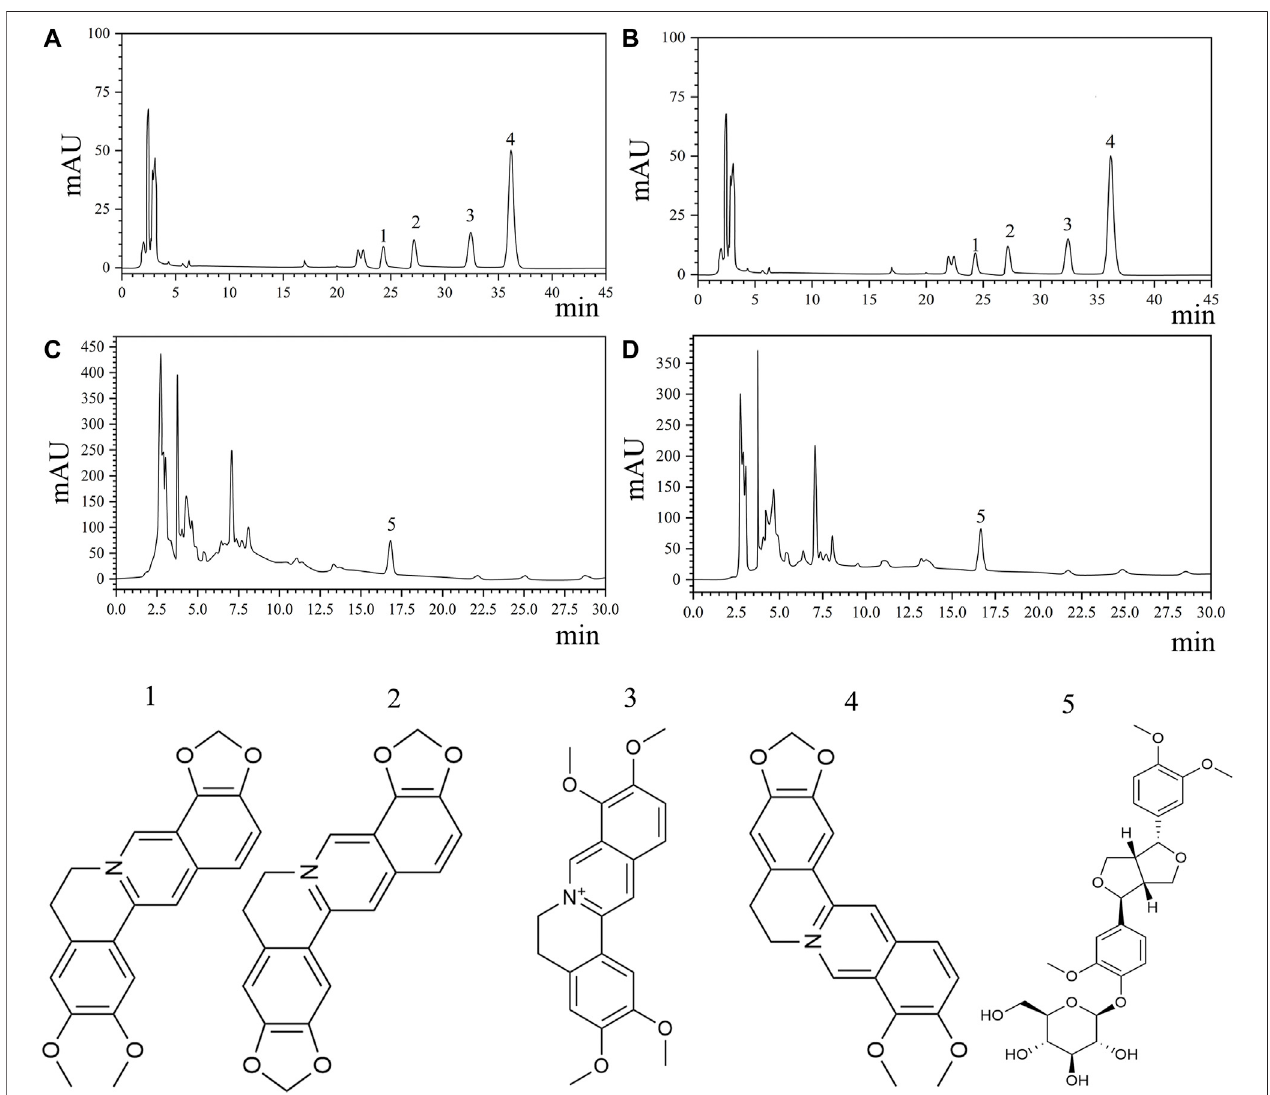
FIGURE 2 | Quantitative analysis of key compounds of THF by HPLC analysis. (A , B) HPLC analysis and chemical structures of four major ingredients of HL. 1. Epiberberine